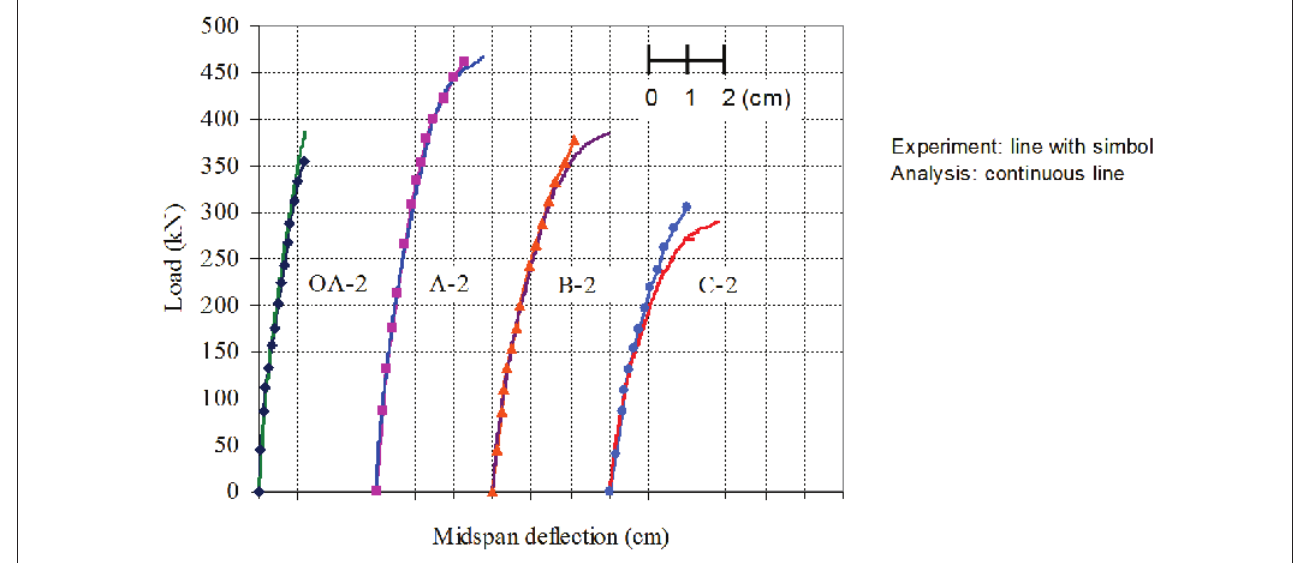
Figure 11 – Load-deflection curves for the tests by Bresler and Scordelis 1963: Series 2